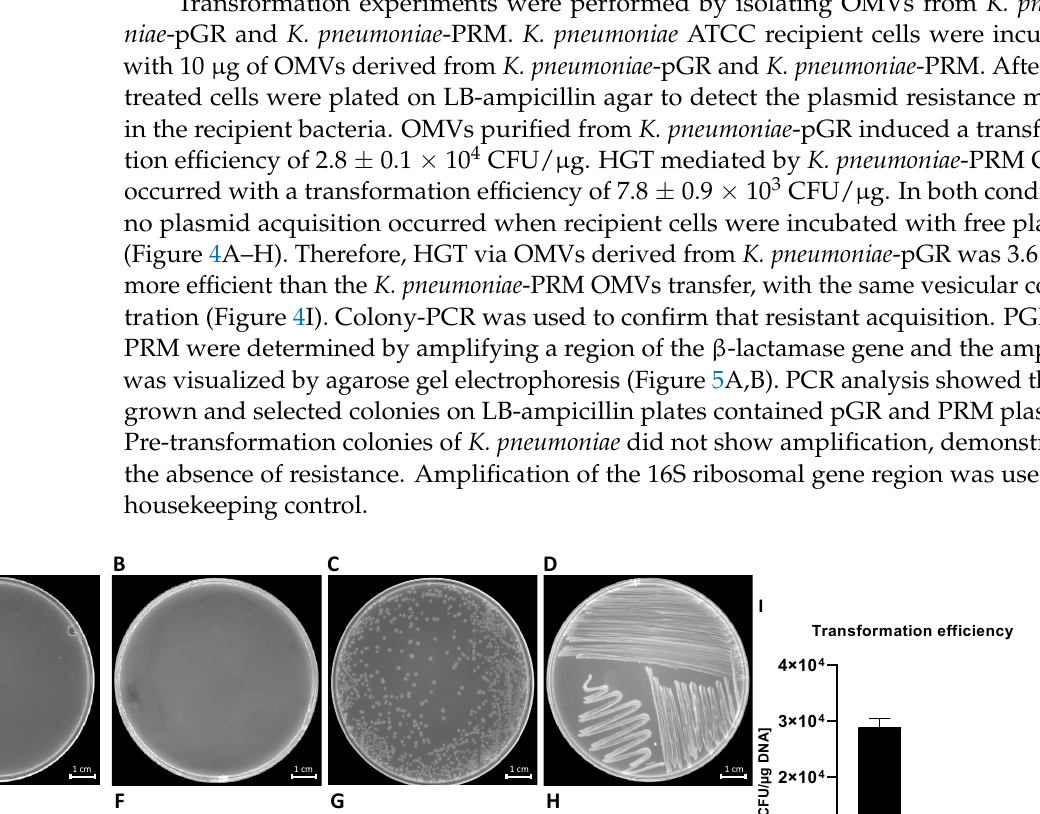
Figure 3. Determination of PCN in OMVs, using quantitative PCR standard curves. The standard curves were generated by qPCR of the purified pGR ( A ) and PRM ( B ) plasmids. Histogram Graph of PGR and PRM cargo efficiency, before and after DNase treatment ( C ) ** p value < 0.005, *** p value < 0.0005.